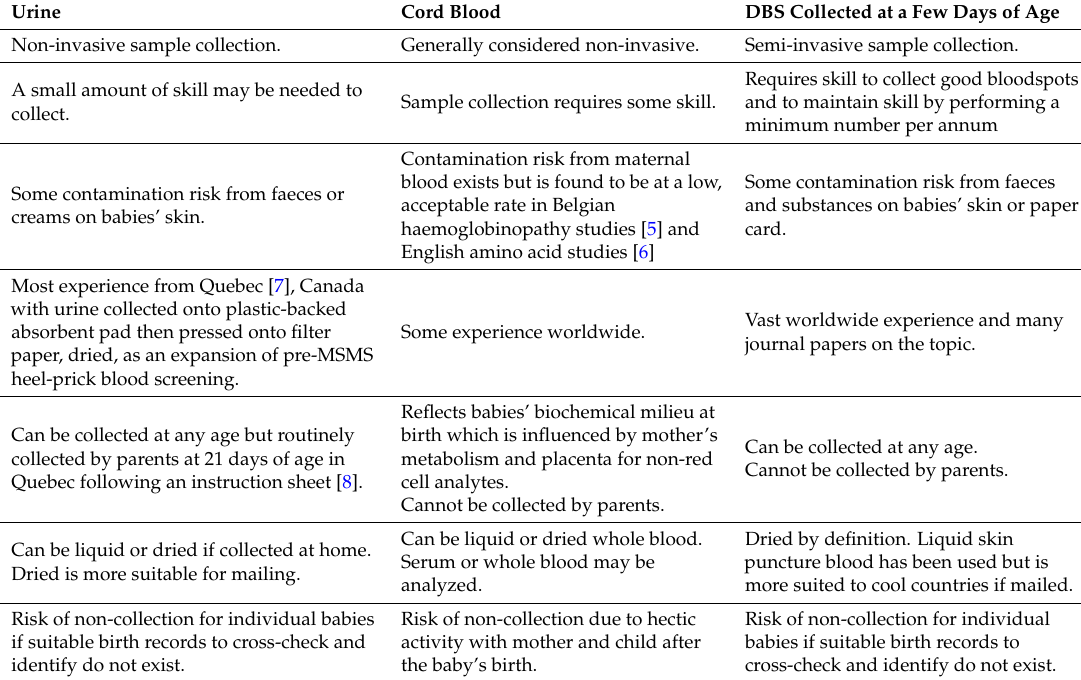
Table 1. Factors affecting newborn biochemical screening